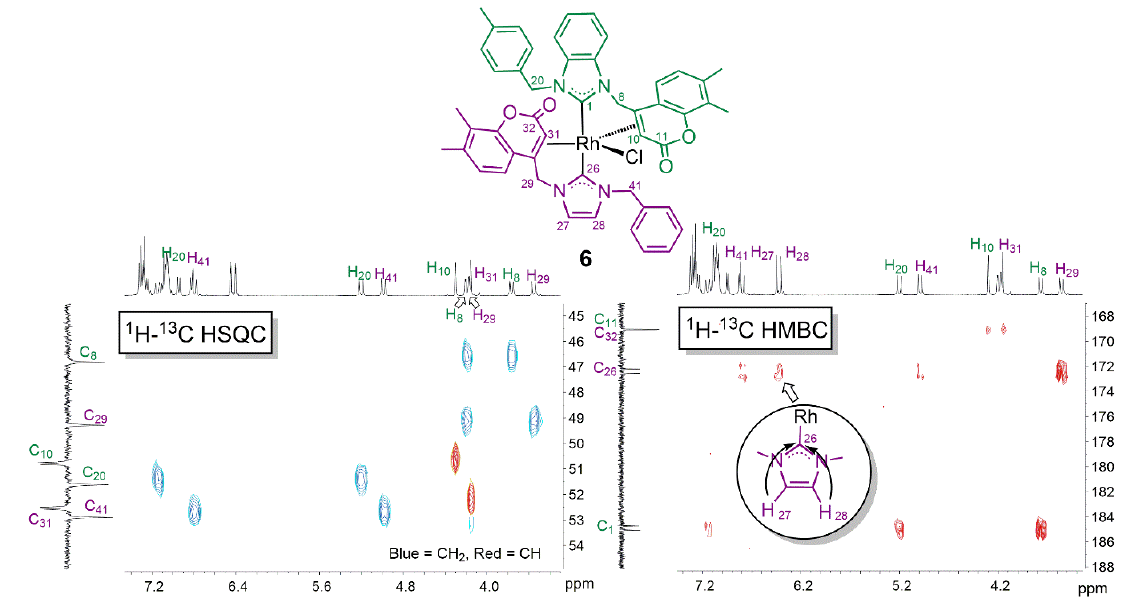
Figure 4. Selected areas of 2D-NMR correlation spectra for 6 : 1 H- 13 C HSQC ( left ) and 1 H- 13 C HMBC ( right ).